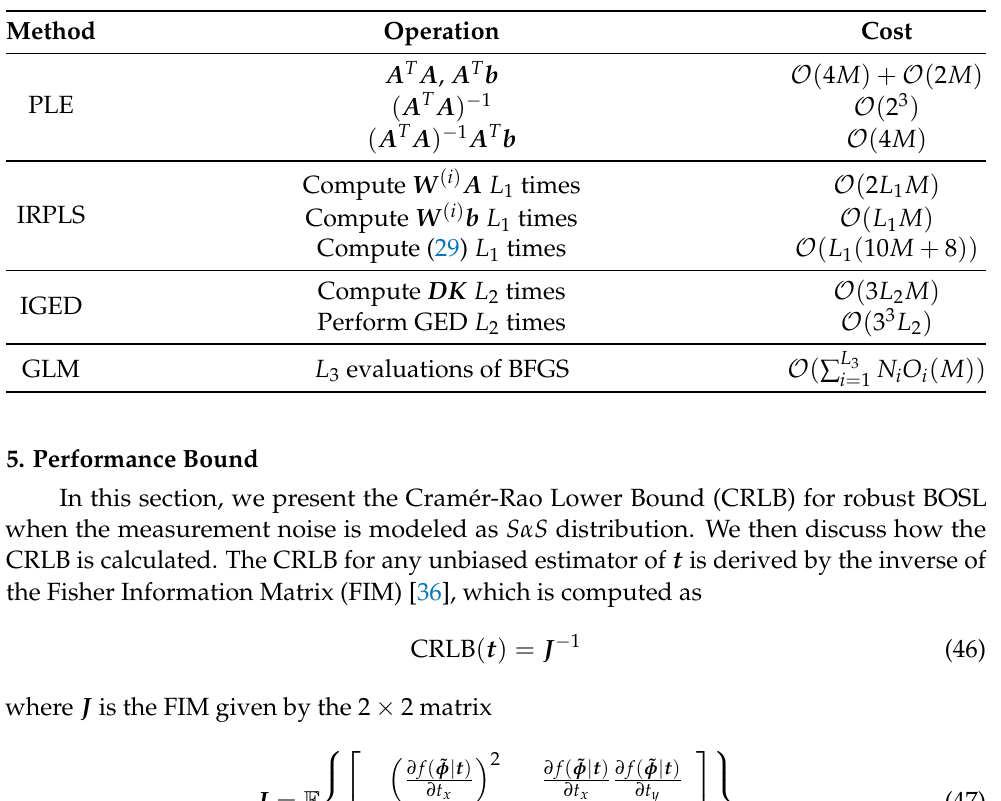
Table 1. Computational